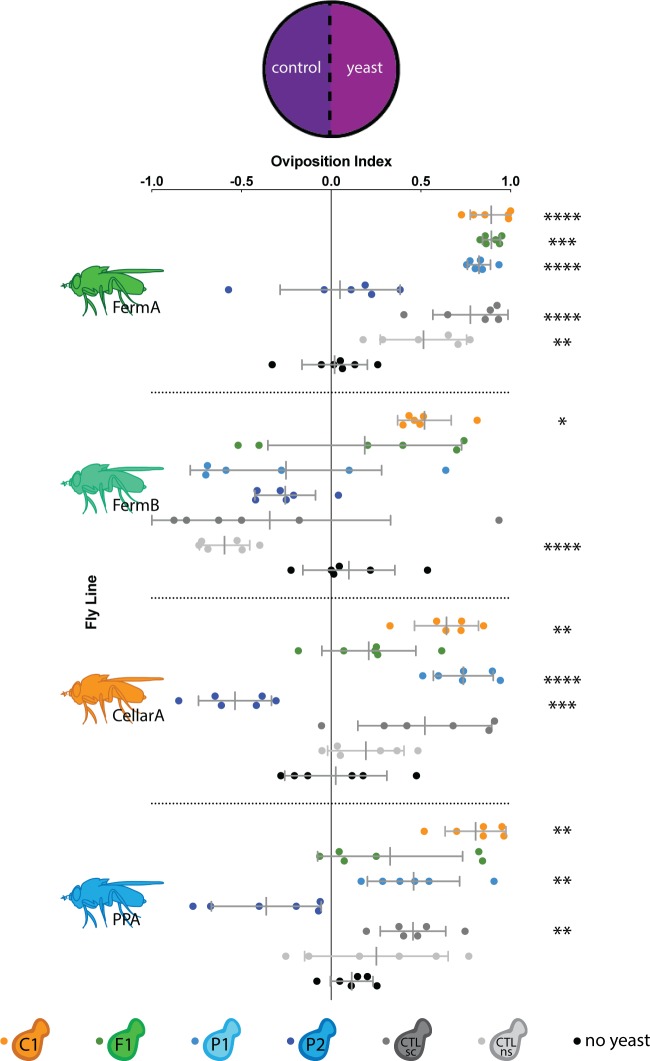
Most fly-associated yeasts elicit a generally positive oviposition response with variability between fly lines.A positive OI indicates an ovipositional preference for the yeast side, a negative OI indicates an ovipositional preference for the control side, and an OI of 0 indicates no preference. Drosophila lines tested are denoted by fly icons to the left. Individual replicates are represented by dots and are color-coded by yeast species. Short grey lines represent standard deviation and longer grey lines represent the mean of all trials. Stars to the left denote significantly different oviposition preferences between the two sides (multiple t-tests with a Bonferroni correction, *: p<0.05, **: p<0.01, ***: p<0.001, ****: p<0.0001).